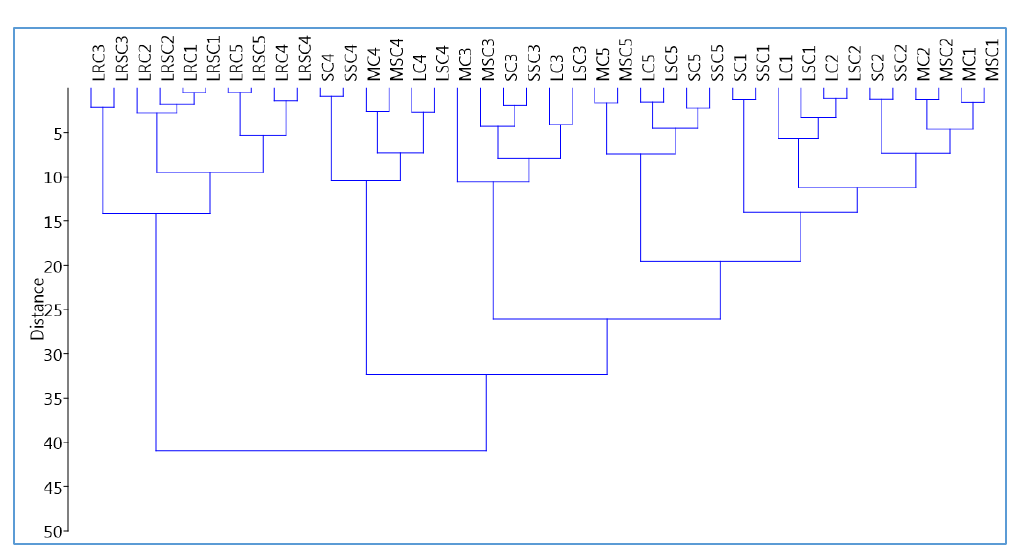
Figure 3. Hierarchical cluster analysis (HCA) of the four wines during 12 months of bottle storage. Samples: LRC, LRSC, Lagrein rosé closed with conventional or ’blend’ stopper, respectively. SC and SSC, St. Magdalener with conventional or ‘blend’ stopper. LC, LSC, same for Lagrein. MC, MSC, Merlot. Storage in bottle: 1 , wine just after bottling; 2 , 3 , 4 , 5 , wine analyzed one, three, six and 12 months after bottling, respectively.